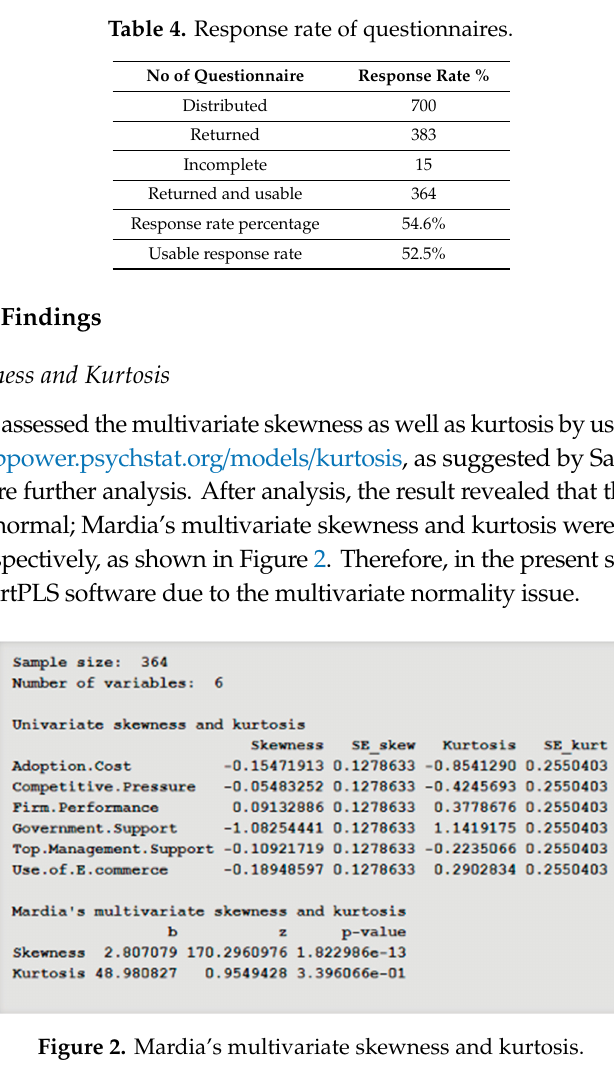
Table 5. Demographic data and respective percentages.